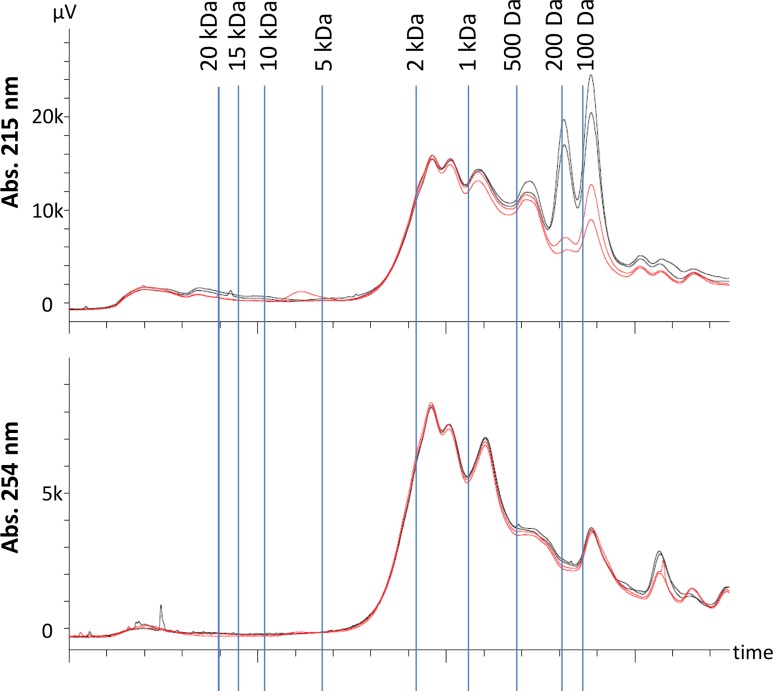
HPSEC of samples from sorption tests with aerobic activated sludge and 1 min mixing.Black lines show controls without addition of sludge. Red lines show samples with addition of 0.97 g/L VSS. The vertical lines show the retention time of polyethylene glycol standards of known molecular weight.